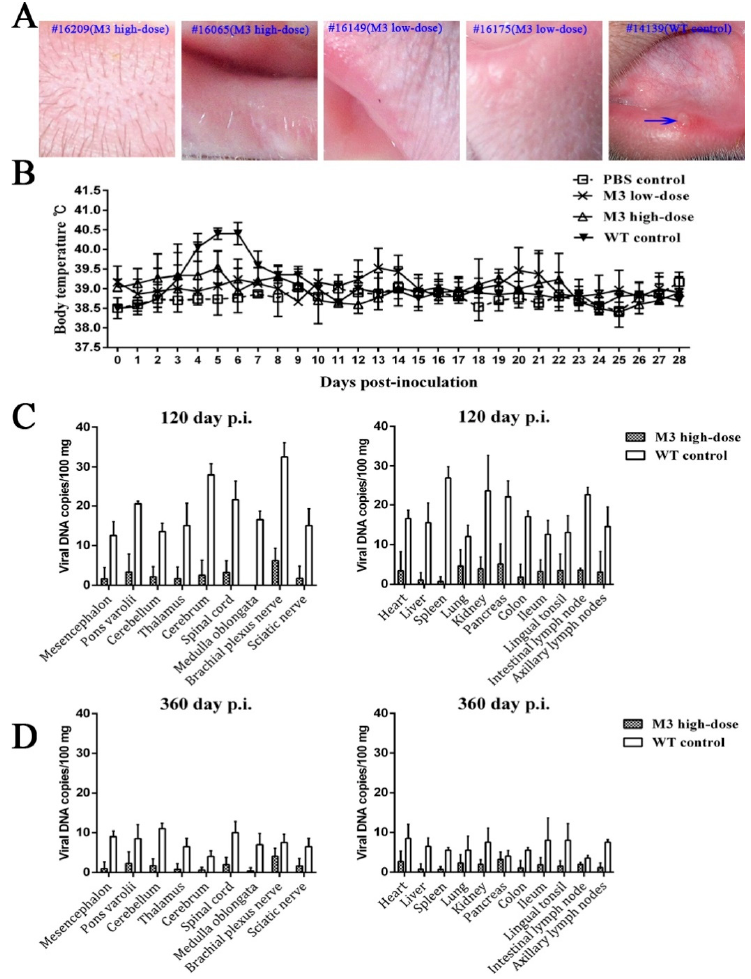
Figure 2. The clinical observations of M3-immunized macaques and the M3 viral DNA copies in various tissues. ( A ) None of the inoculated macaques from the high-dose (#16209 and #16065) and low-dose (#16149 and #16175) groups exhibited symptoms post-immunization compared to the WT control (#14139 was selected as a representative); the vesicle in the lip of #14139 is indicated by the blue arrow. ( B ) The body temperatures of the infected monkeys were measured by the anal route twice each day, post-inoculation. ( C ) M3 distribution in the CNS and other major tissues on day 120, post-immunization, of the high-dose and WT control groups. ( D ) M3 distribution in the CNS and other major tissues on day 360 post-immunization of the high-dose and WT control groups.